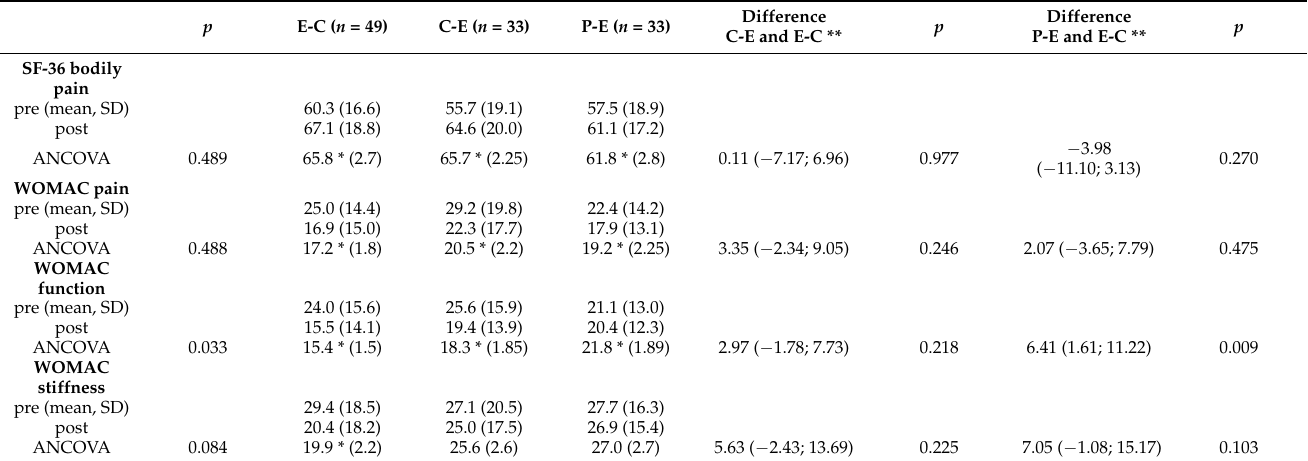
Table 4. ANCOVA for exercise intervention phase adjusted for baseline ( n =